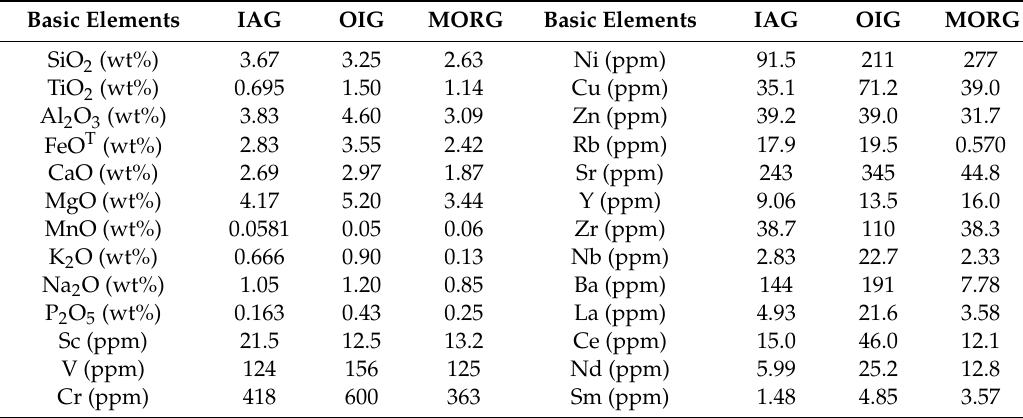
Table 2. Standard deviation of the element contents of IAG, OIG, and MORG